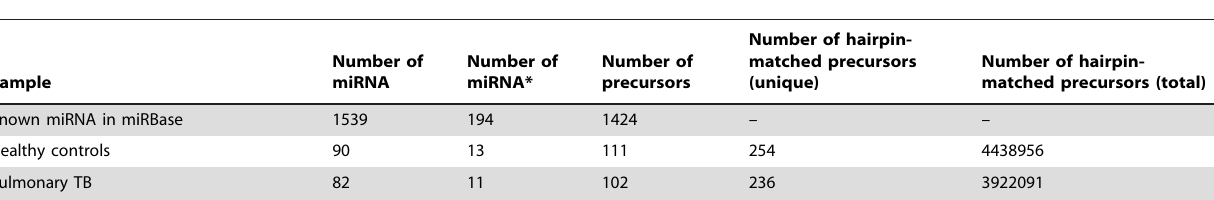
Table 3. The number of miRNAs in pooled serum samples from pulmonary TB and healthy controls by Solexa sequencing analysis.